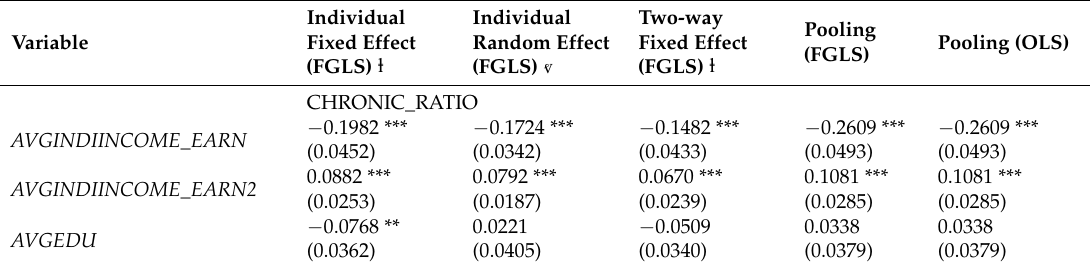
Table 5. Results of the regression analysis on China Health and Retirement Longitudinal Study (CHARLS) dataset.